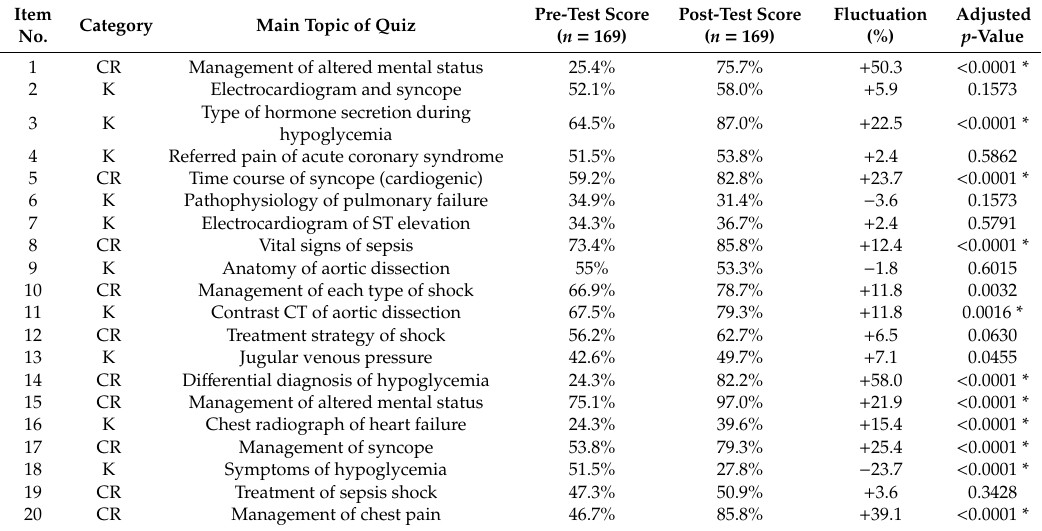
Table 1. Pre-post test